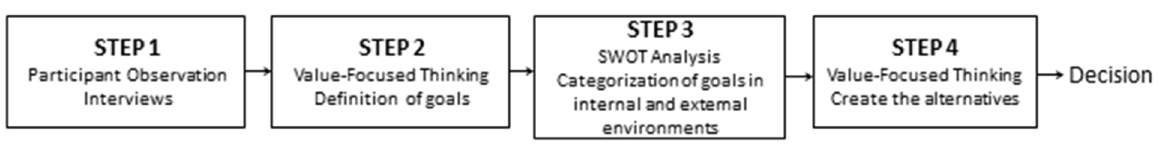
Figure 2. Research Figure 2. Research flowchart.